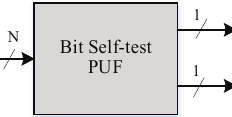
Figure 2. Model of Bit-Self-Test PUF.